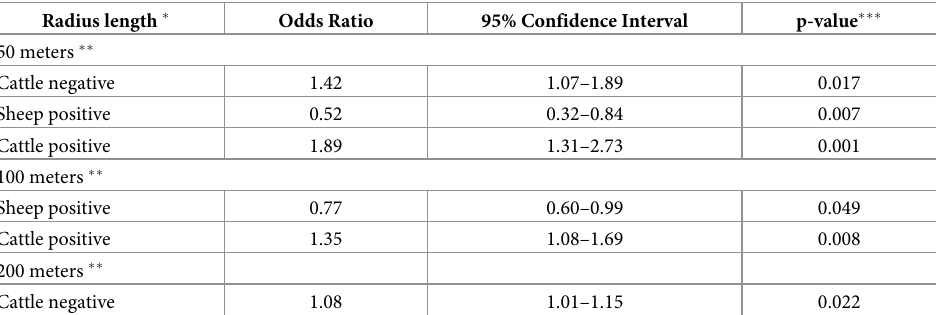
independently of their infection status. However, infected households had a higher likelihood of being close to Fasciola infected cattle feces (OR = 1.89 (95%CI 1.31–2.73), p = 0.007) than to Fasciola negative cattle feces (OR = 1.42 (95%CI 1.06–1.89), P = 0.017). Using a 50-meter radius around households, Fasciola positive sheep feces were associated with a lower likelihood of the household being infected with Fasciola (OR = 0.52 (95%CI 0.32–0.84), p = 0.007). Fas- ciola negative sheep feces (p = 0.939) and swine feces regardless of their infection status (posi- tive p = 0.7711, negative p = 0.7968) were not associated with infection in the households (Tables 4 and S1). Using a 100-meter radius in the adjusted logistic regression model, infected households still had a higher likelihood of having Fasciola positive cattle feces in their sur- roundings as compared to uninfected households (OR = 1.35 (95%CI 1.08–1.69), p = 0.049) but had a decreased likelihood of having Fasciola positive sheep feces (OR 0.77 (95%CI 0.60– 0.99), p = 0.042). Any swine feces and Fasciola negative cattle or sheep feces showed no Table 4. “Multivariable logistic regression modeling factors assessing the likelihood of household positivity status by proximity to different types of livestock feces under different distance